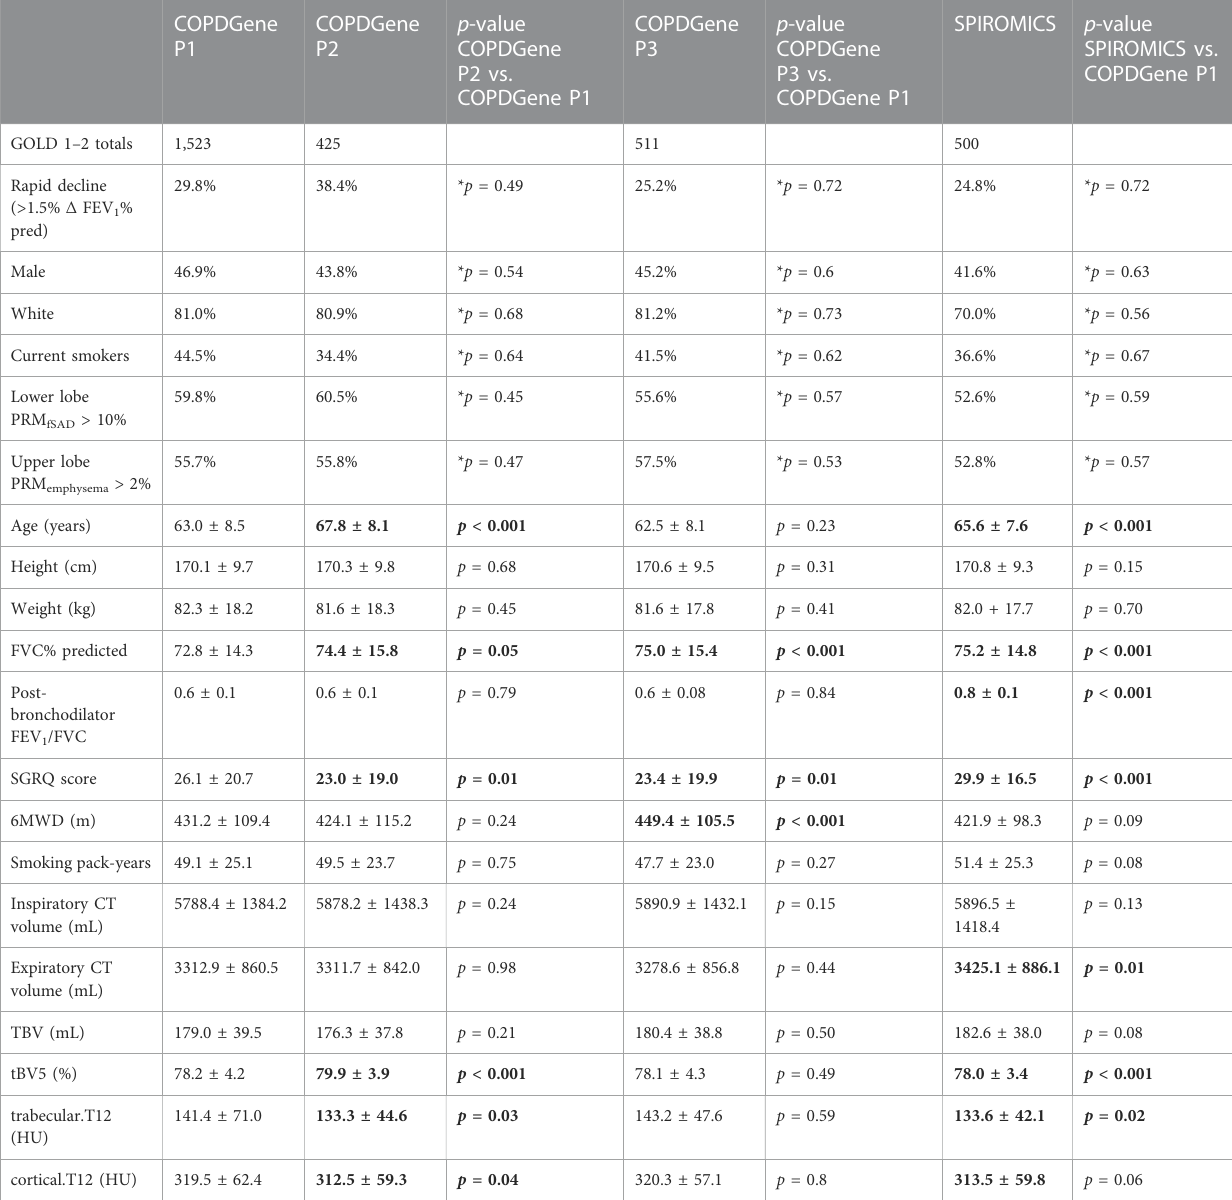
TABLE 2 Summary statistics for COPDGene Phase 1, COPDGene Phase 2, and SPIROMICS cohorts for GOLD 1 – 2 subjects. COPDGene COPDGene P1